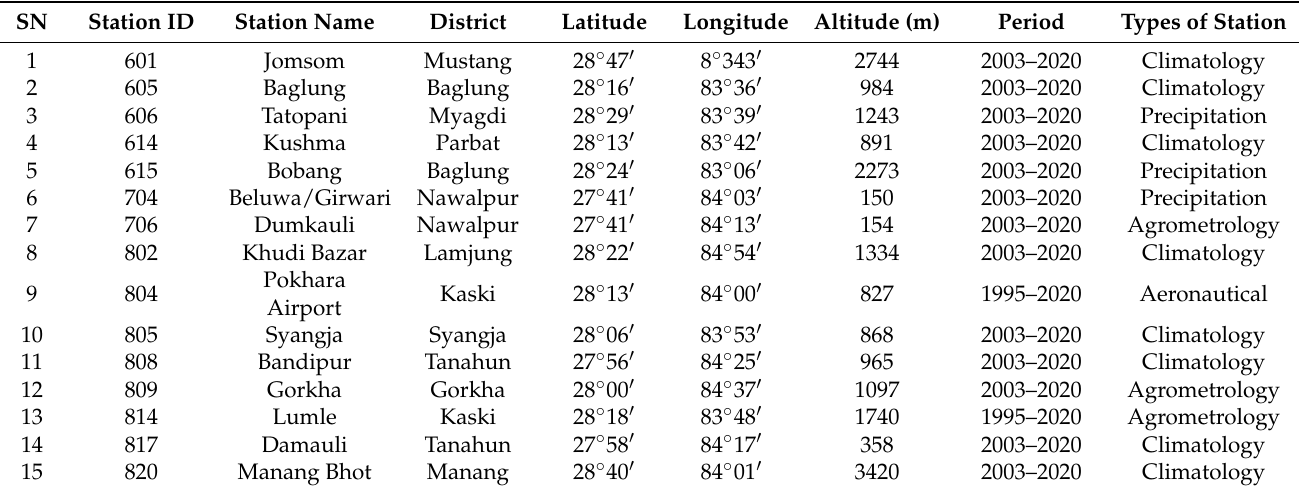
Table 1. List of meteorological stations used in this study.